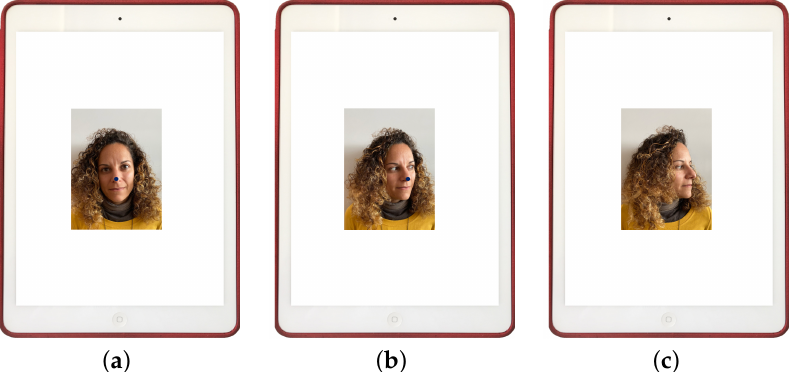
Figure 3. Simulated stages of the experiment procedure for the left rotation movement on the apparatus: ( a ) participant placed in the initial position with the nose point returned by the head- tracker marked with a blue circle, ( b ) the participant starts a rotation movement slowly (the nose point returned by the head-tracker is marked with a blue circle), ( c ) moment when the head-tracker loses the position of the nose (an acoustic alert is triggered) and the participant stops its movement. Flexion and extension were measured with the axis over the external auditory mea- tus, with the stationary arm parallel to ground and the movement arm in line with the base of nares. Lateral flexion was measured with the axis over spinous process of C7 vertebra, with the stationary arm in line with spinous processes of thoracic vertebrae, so that arm was perpendicular to ground, and the movement arm in line with occipital protuberance. Rotation was measured with the axis located over central aspect of head, with the stationary arm parallel to imaginary line between the two acromial processes, and the movement arm in line with the tip of the nose. All measurements were conducted by an experienced